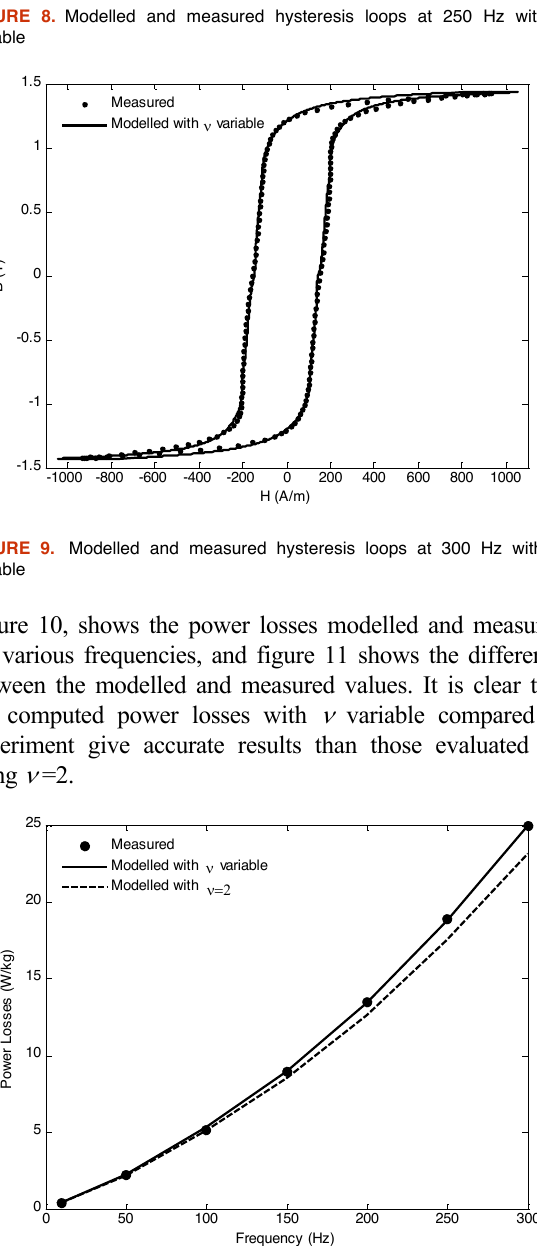
FIGURE 10. Evolution of power losses modelled and measured at different frequencies